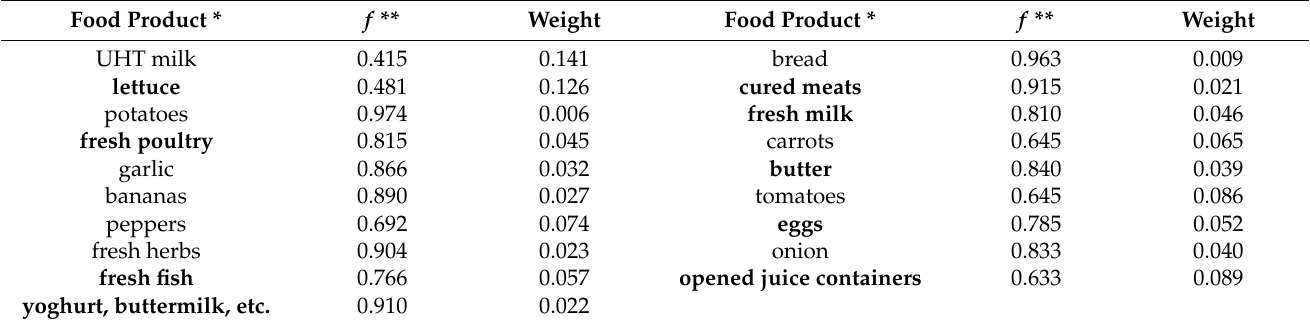
Table A3. Frequency of showing correct answers ( f ) regarding the storage of food products (P:4). Food Product